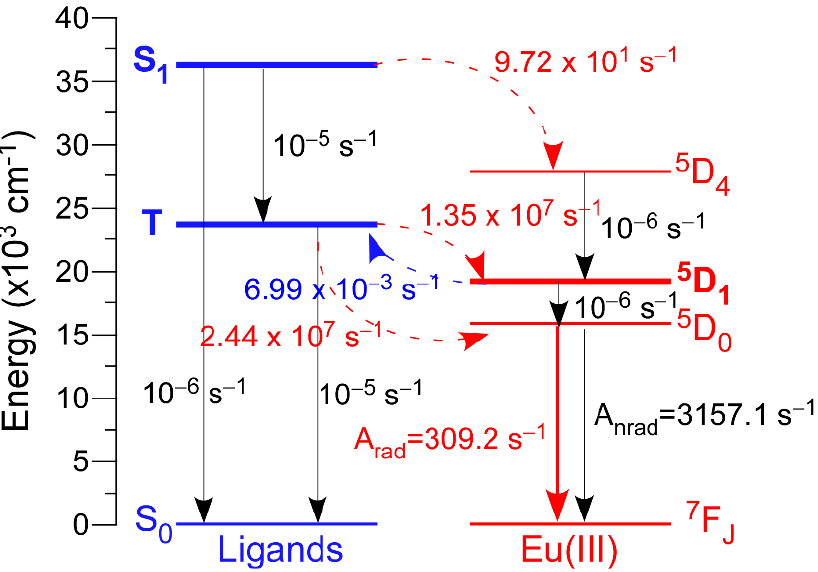
Figure 4. Schematic diagram of the main states involved in the luminescence of compound 2 Eu using model 2-Eu-1 showing the main calculated energy transfer rates. Dotted lines represent the ligand-to-metal (red) and reverse (blue) transfers.